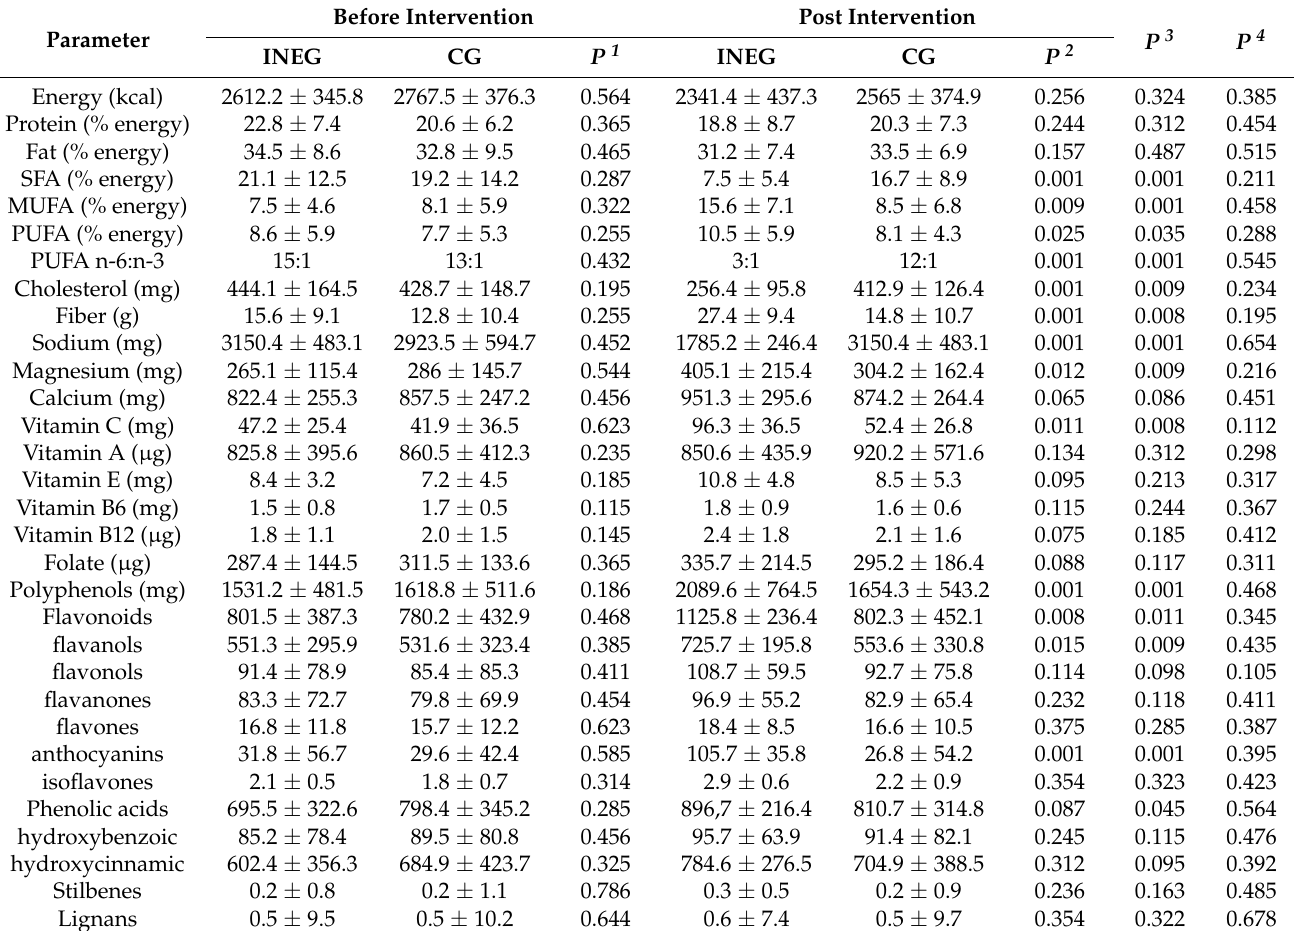
Table 3. Changes in nutritional value of the diet at baseline and 3-months